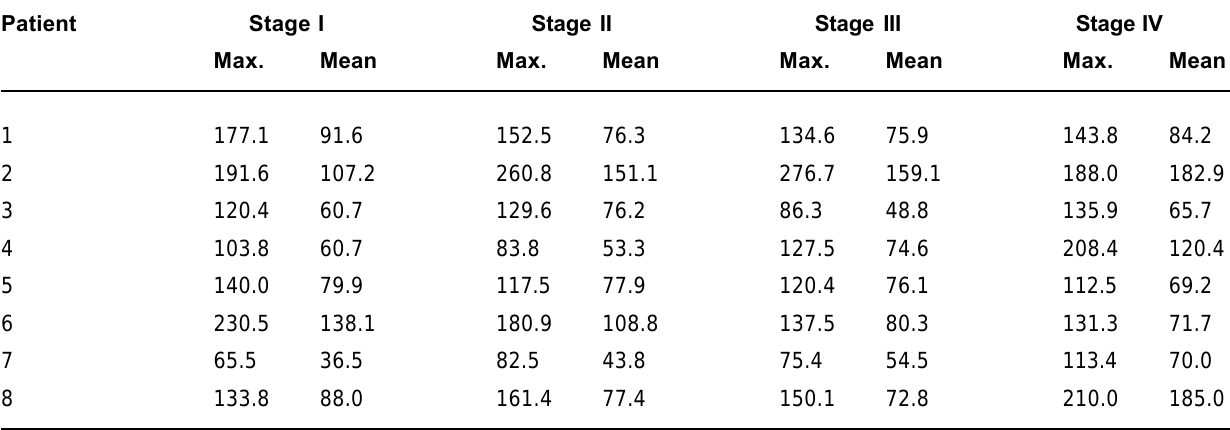
TABLE 4 - Maximum and mean mandibular speed during opening movement (in millimeters per second)